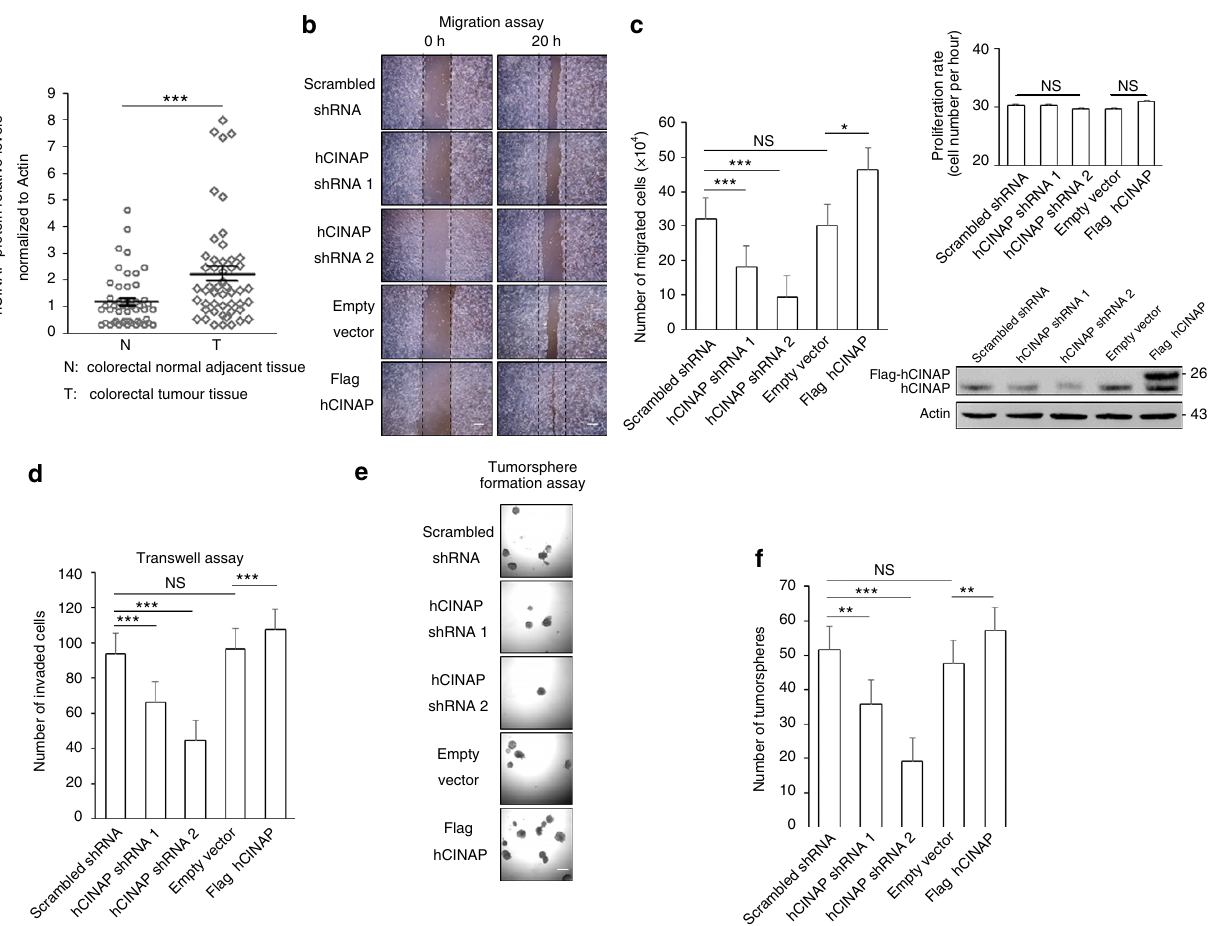
Figure 1 | hCINAP promotes invasiveness and metastasis in CRC cells. ( a ) Western blot analysis of the hCINAP protein levels in human CRC and adjacent paired normal tissues, normalized to Actin ( n ¼ 50). See also Supplementary Fig. 1. ( b ) The wound-healing assay using SW480 cells expressing the indicated shRNAs and plasmids. Scale bar, 100 m m. ( c ) Quantification of the migration potential and proliferation rate of the cells in the migration assay ( n ¼ 3 wells each group) and western blot analysis of the hCINAP and Flag-hCINAP expression. ( d ) Quantification of invaded cells in the transwell assay ( n ¼ 3). ( e ) Tumorsphere formation assay using CRCSCs transfected as indicated. Scale bar, 100 m m. ( f ) Quantification of the tumorsphere formation assay ( n ¼ 3). Asterisks indicate significant differences (* P o 0.05, ** P o 0.01, *** P o 0.001) determined by Student’s t -test ( a , c , d , f ). NS, not